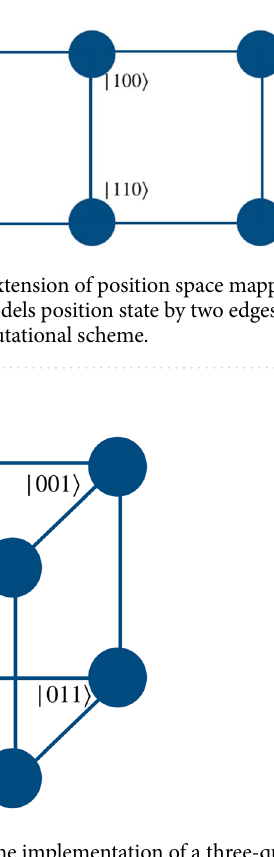
Figure 14. An illustration of the implementation of a three-qubit (eight point) position space for higher-qubit